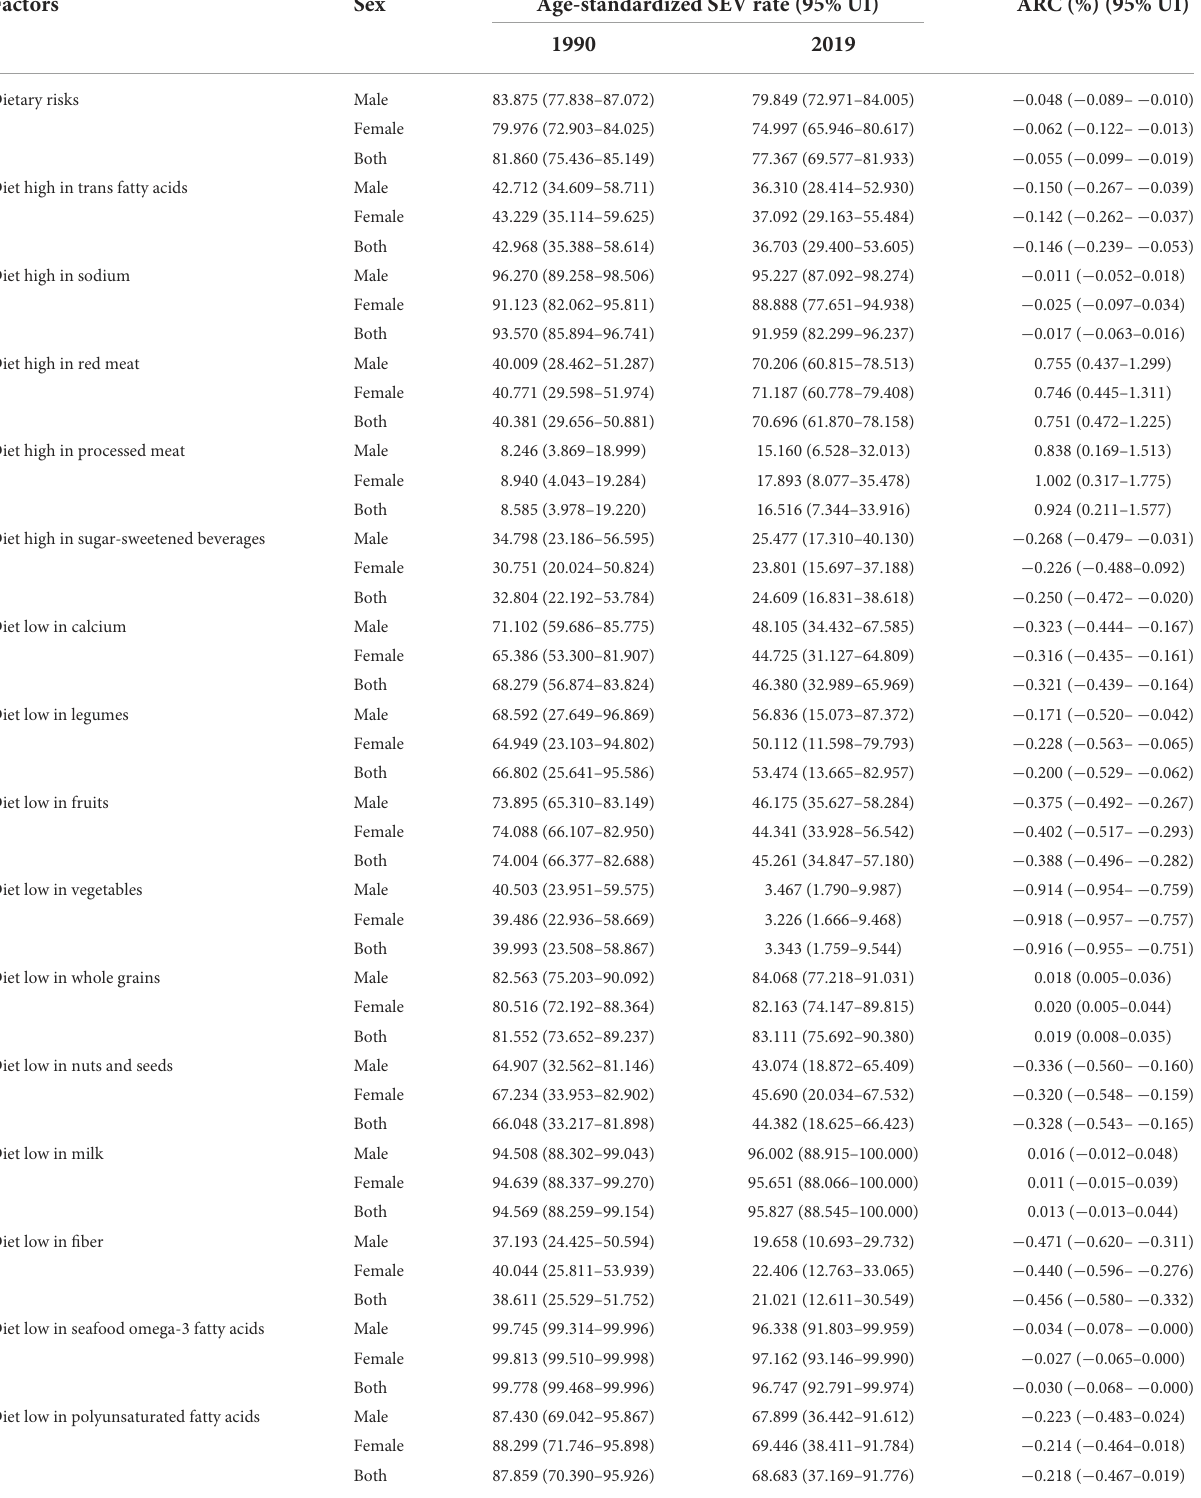
TABLE 2 The age-standardized SEV rates of dietary risks in 1990 and 2019, and annualized rate of changes in China.